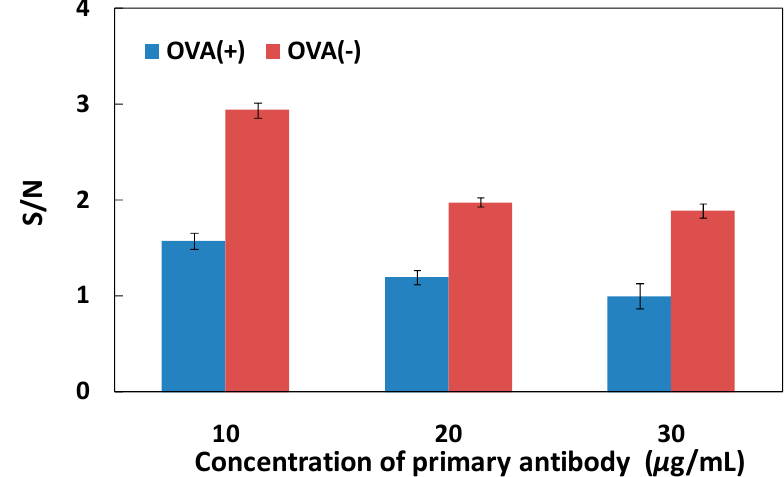
Figure 6. S/N ratio for antigen detection with different primary antibody concentrations, for covalent immobilization on the (PDDA/PAA) 3 substrate with, and without, OVA adsorption ( n = 3).